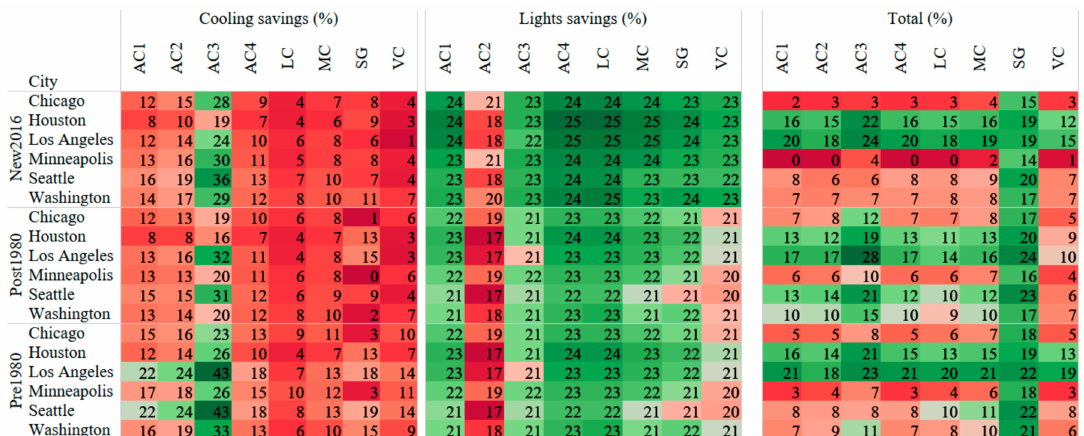
Figure 4. Energy savings relative to baseline case resulting from other shading attachment and / or lighting control strategies in di ff erent vintages and locations. (Color diverges from green to red for higher to lower relative energy